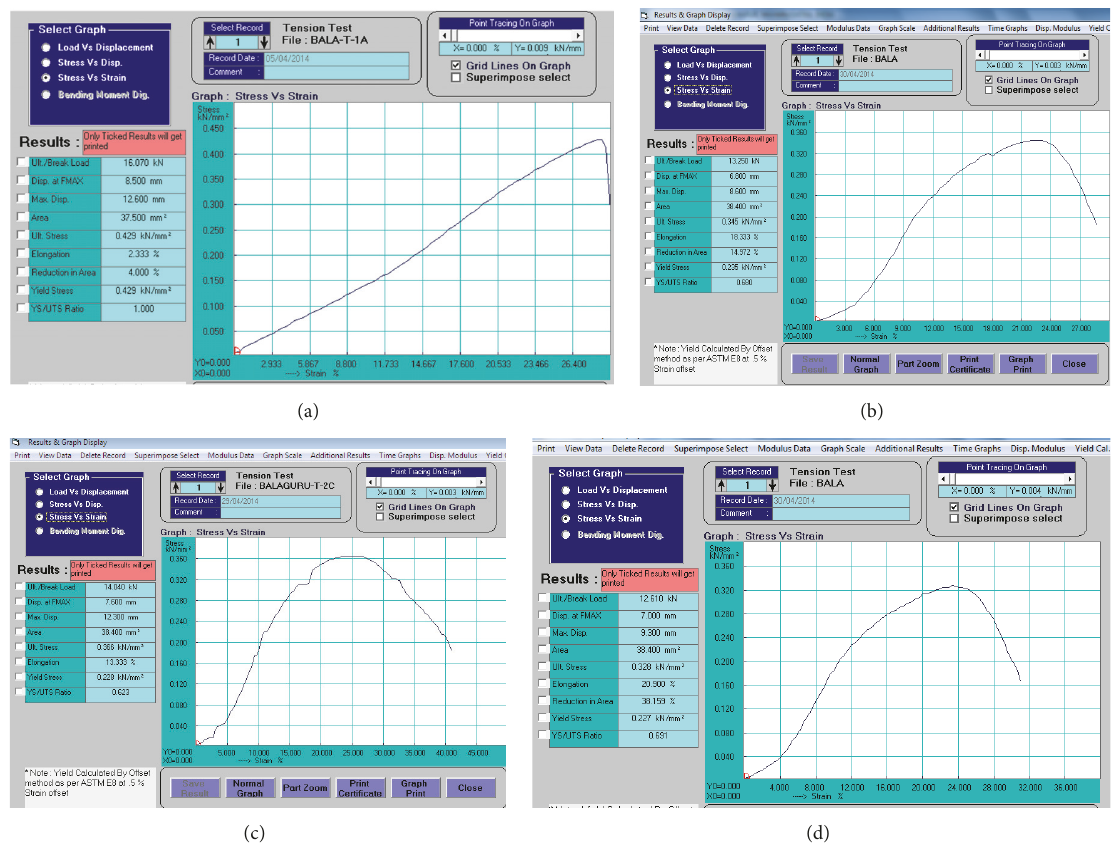
Figure 7: Stress-strain graphs of the weldment at (a) room temperature, (b) 200 ∘ C, (c) 400 ∘ C, and (d) 550 ∘ C.